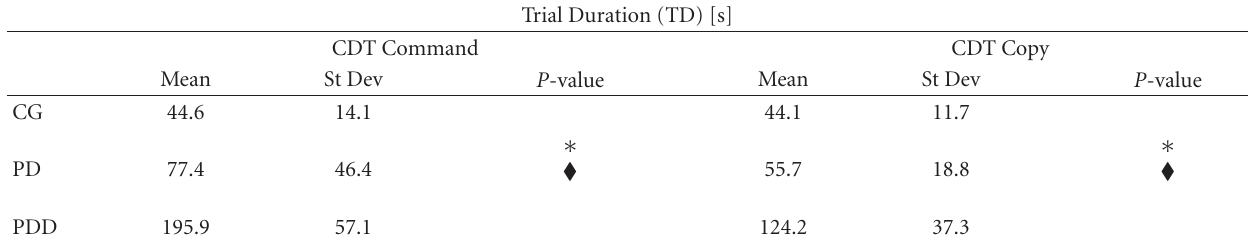
Table 2: Trial duration (mean and standard deviations) for the three groups and for both drawing conditions.